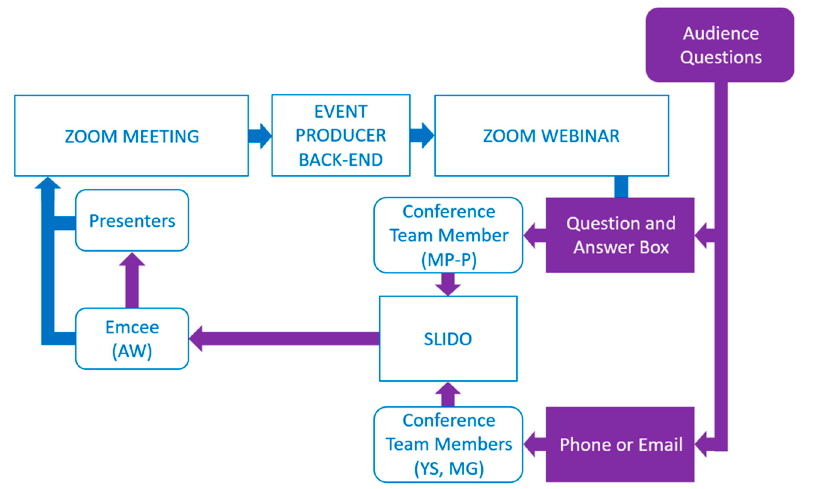
Figure 3. This diagram shows our approach to receiving and having audience questions answered by the presenters.